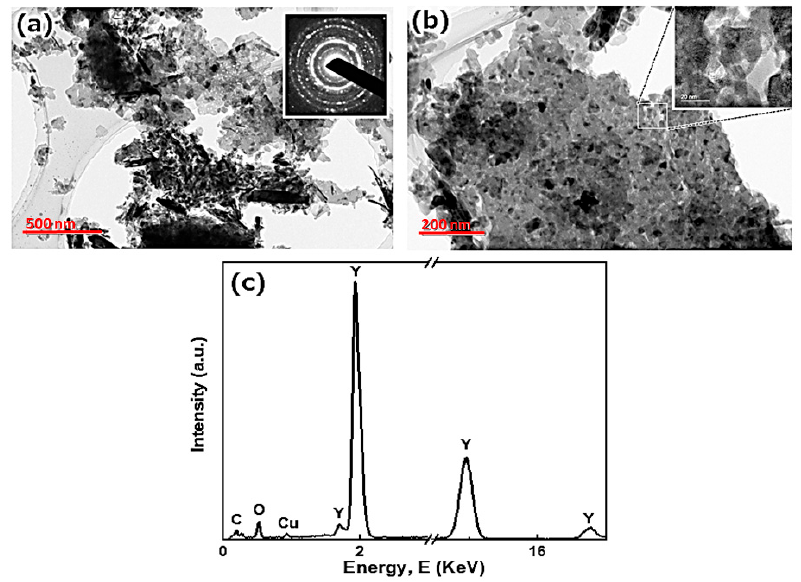
Figure 5. ( a ) BF-TEM and SAD pattern of the ball-milled Y 2 O 3 powder. ( b ) Magnified BF- and HR- TEM images of the plate-like particle. ( c ) EDS spectra taken from ( a ).